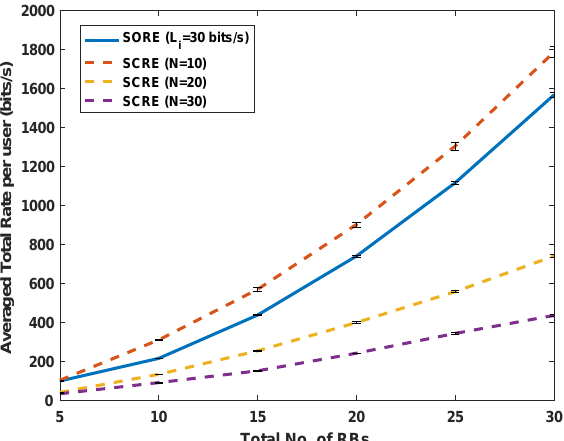
Figure 7. Averaged Achievable data rates per user by changing No. of Total RBs using 10, 20, 30 UEs in Cooperative Communication and 20 UEs with 30 leftover capacity in Wi-Fi offloading and overall 3